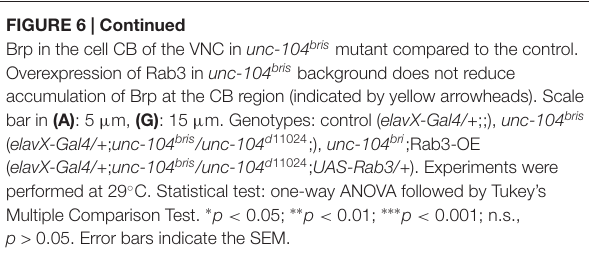
FIGURE 6 | Continued Brp in the cell CB of the VNC in unc-104 bris mutant compared to the control. Overexpression of Rab3 in unc-104 bris background does not reduce accumulation of Brp at the CB region (indicated by yellow arrowheads). Scale bar in (A) : 5 µ m, (G) : 15 µ m. Genotypes: control ( elavX-Gal4/+ ;;), unc-104 bris ( elavX-Gal4/+ ; unc-104 bris /unc-104 d 11024 ;), unc-104 bri